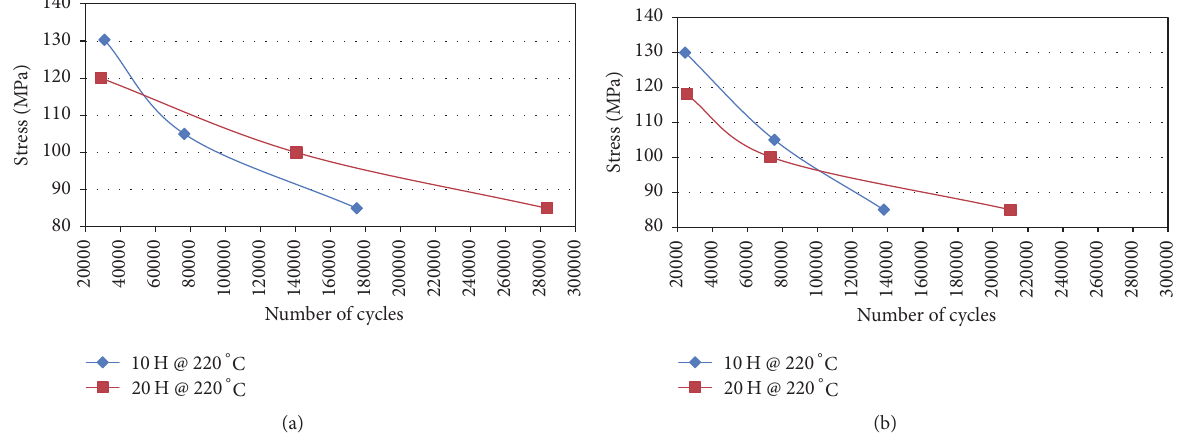
Figure 12: S-N curves for (a) DCM3 alloy and (b) DCM5 alloy.